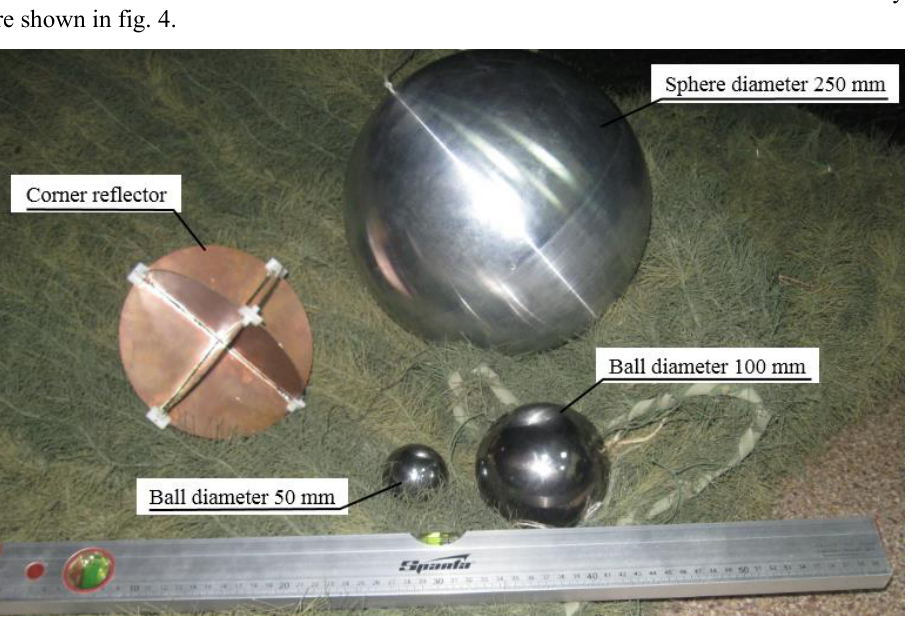
Fig. 4. The reference reflectors in the RCS measurement